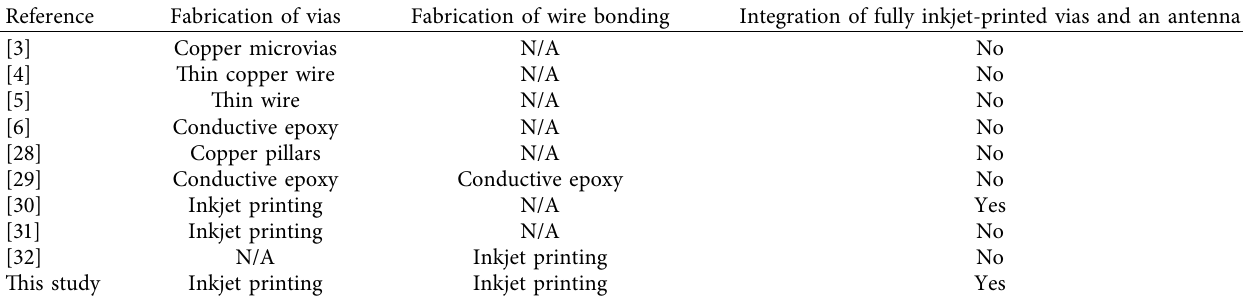
Table 1: Distinct features of the proposed